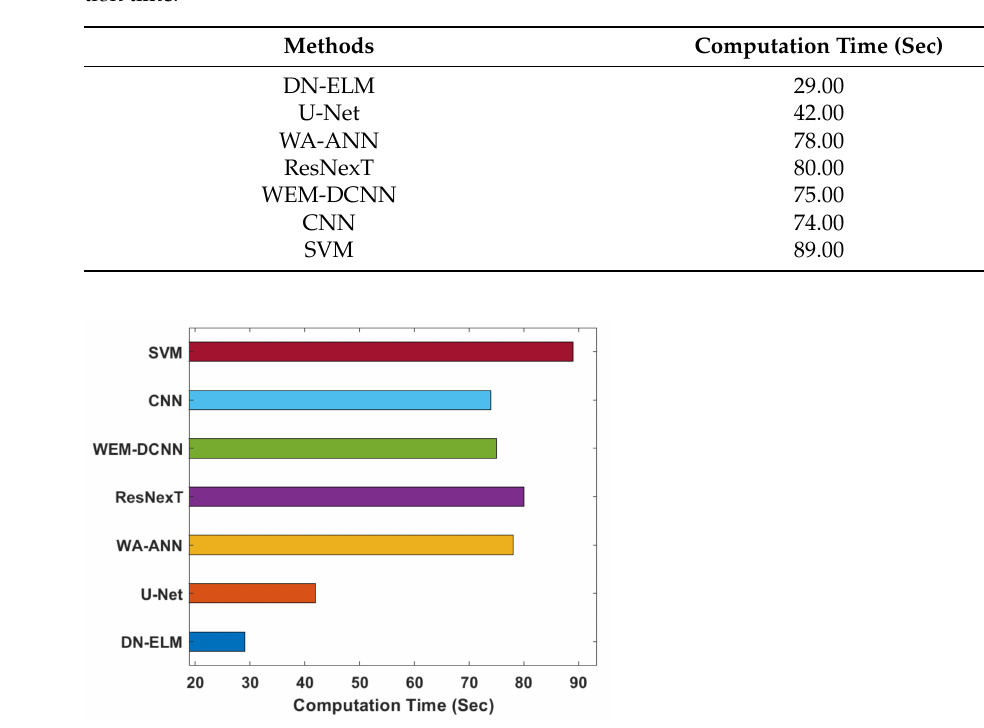
Table 2. Result analysis of the proposed DN-ELM model with existing methods in terms of computa- tion time.